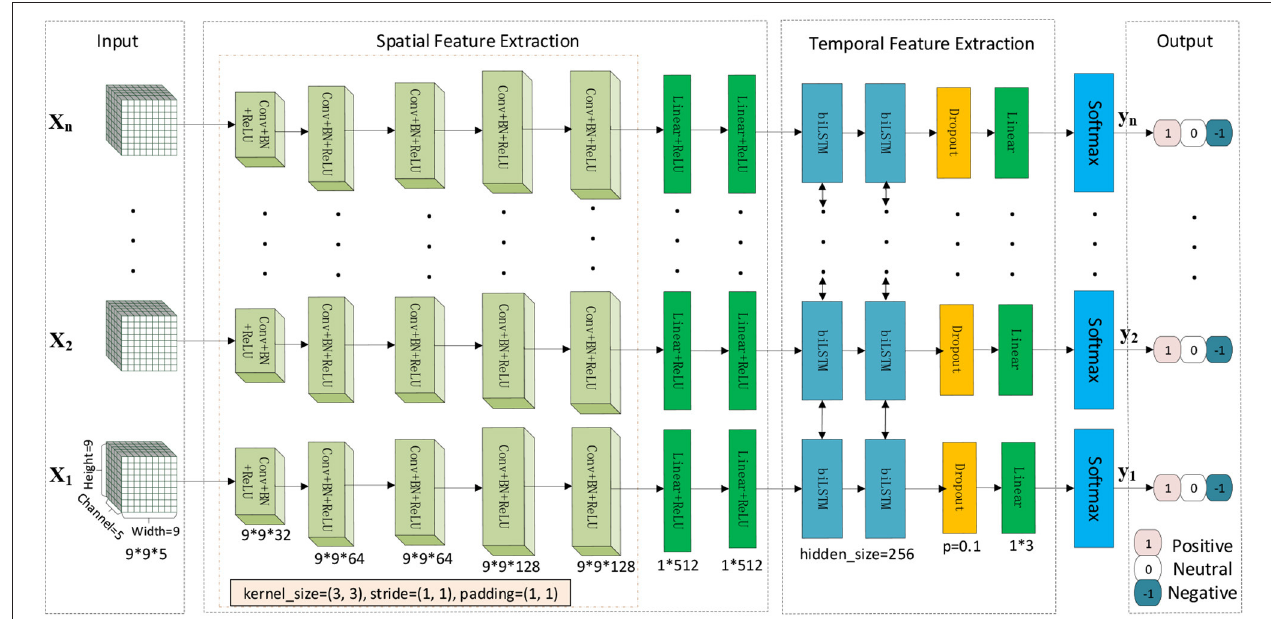
FIGURE 3 | Cascade 2dCNN + BiLSTM